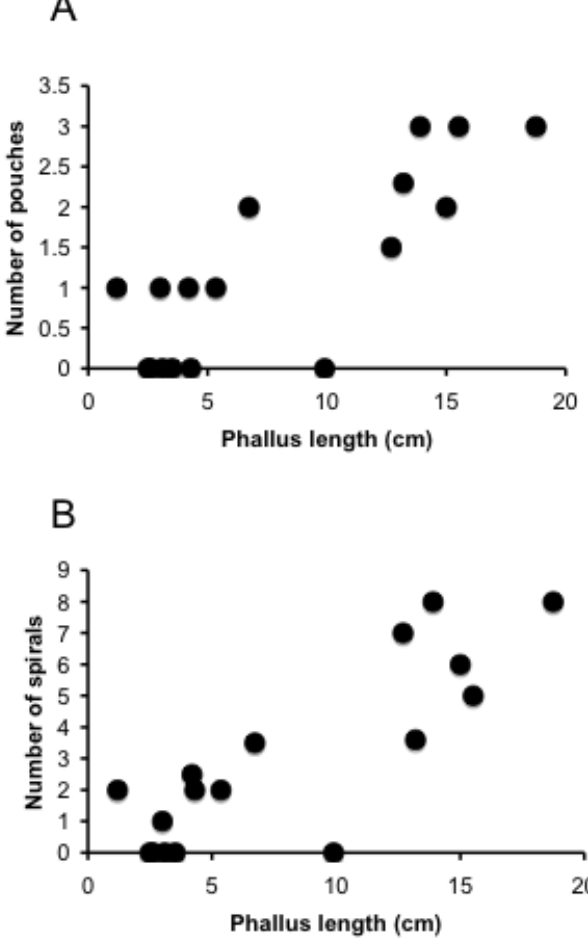
Figure 3. Relationships between male phallus length and female vagina. (A) Phallus length vs. number of vaginal pouches. (B) Phallus length vs. number of vaginal spirals. Points are the averages for each species